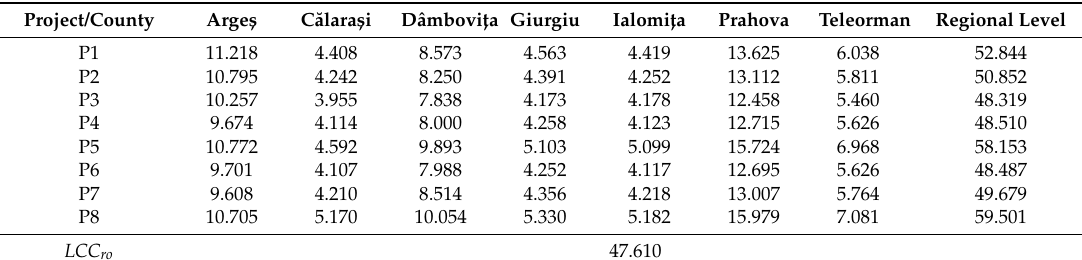
Table A3. LCC at the regional level for the maximum scenario (billions